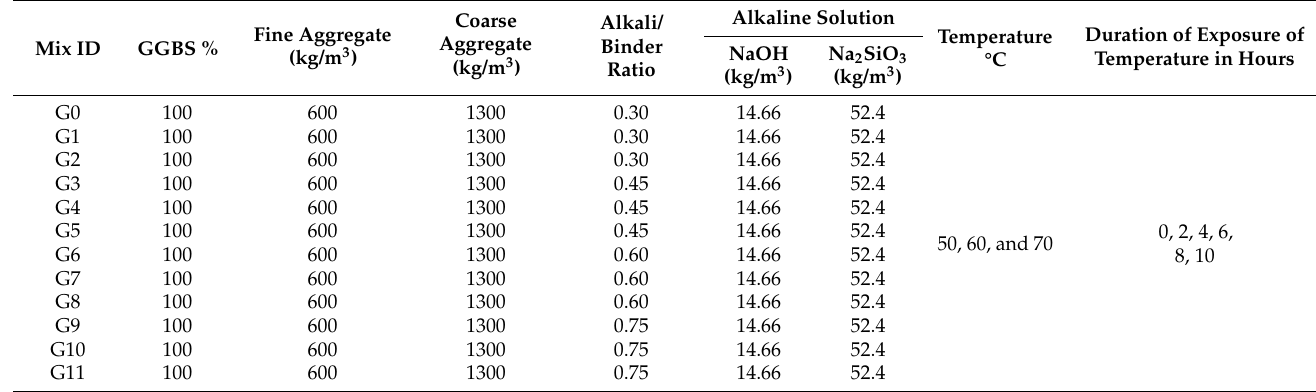
Table 3. Mix proportion of